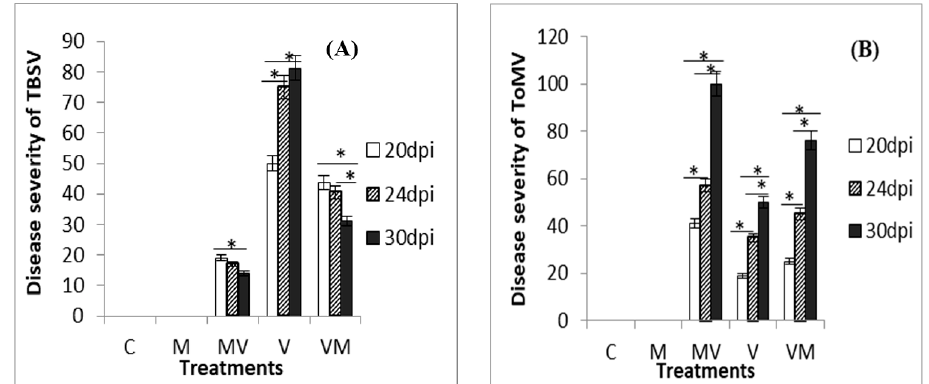
Figure 1. Disease severity of tomato plants infected by TBSV ( A ) and ToMV ( B ) at 20, 24 and 30 dpi (days post inoculation) of uninfected control plants without AM fungi (C), uninfected control plants with AM fungi (M) TBSV/ToMV-infected plants without AM fungi (V), TBSV/ToMV-infected plants before mycorrhiza (VM) inoculation and inoculated plants with mycorrhiza before TBSV/ToMV infection (MV). DS = Disease Severity for three replicates calculated. Significant difference between the disease severity of treatments at three times is shown by (*) [using repeated measures ANOVA and Bonferroni post-hoc test ( p < 0.05)]. Error bars represent